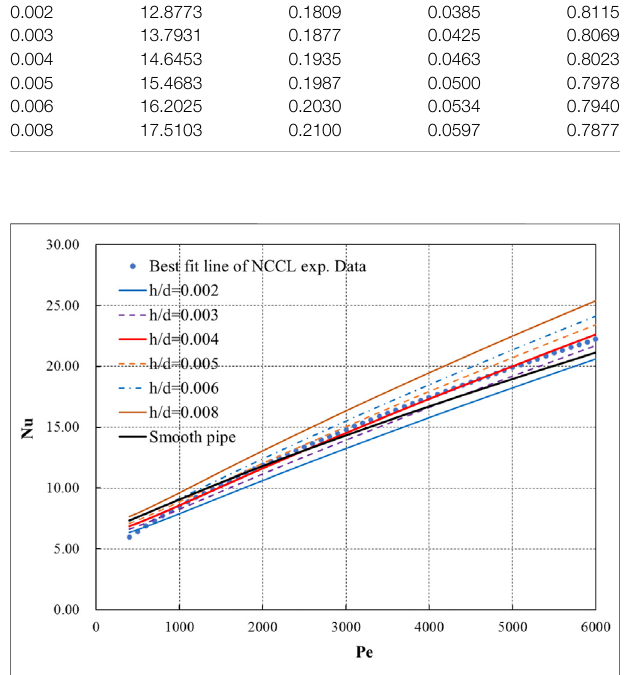
FIGURE 8 | Results of Eq. 30 for different relative roughnesses.